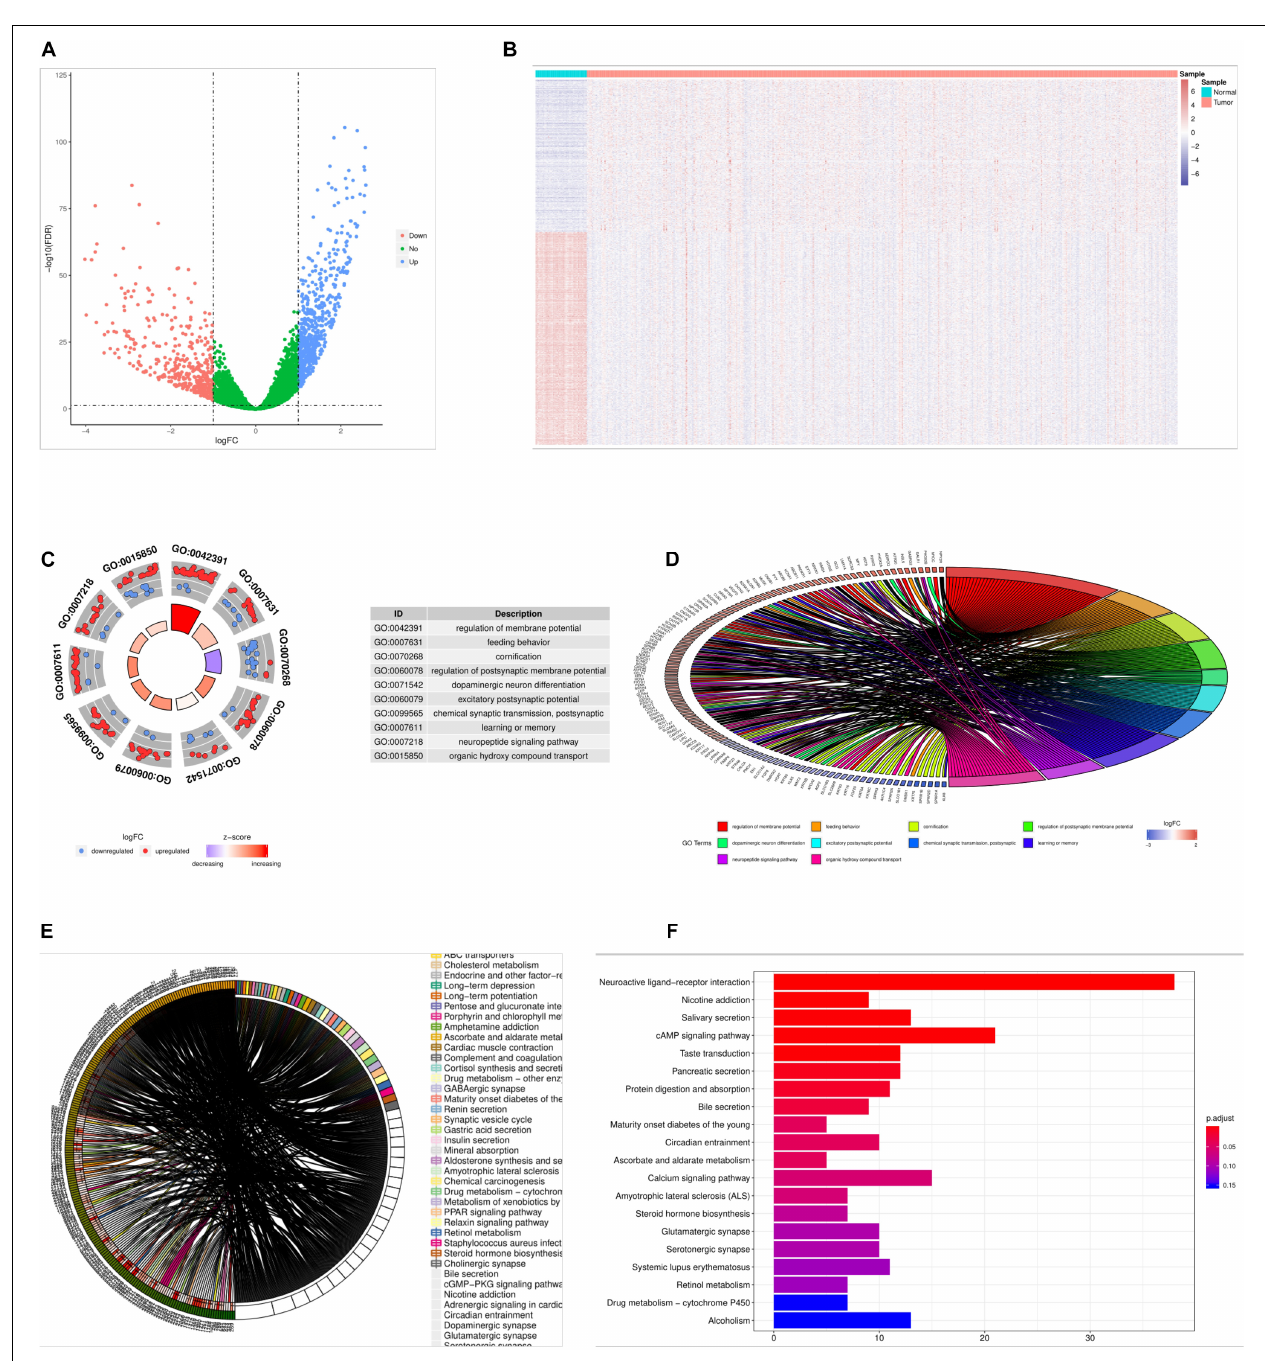
FIGURE 1 | Results of differential gene analysis. (A) volcano plot of differentially expressed genes, the horizontal axis is the differential expression multiple (Log2FC), the longitudinal axis is—log10(fdr), the blue point is the up-regulated gene, and the red point is the down-regulated gene. (B) The heat map of the differentially expressed genes, the horizontal axis is the sample, the longitudinal axis is the different genes, the red indicates the high expression of the gene, and the blue indicates the low expression of the gene. (C) Circle graph of the top 10 GO terms with the most enriched genes. (D) Enriched the first 10 GO term and chord graphs with the largest number of genes, the right semicircle represented 10 GO term, the left semicircle represented the genes enriched in these 10 GO term. (E) Chord diagram of the main KEGG signaling pathway for gene enrichment. (F) Top 20 KEGG pathway, with the largest number of enriched genes, the horizontal axis of the map indicated the number of genes enriched, and the longitudinal axis indicated the names of each